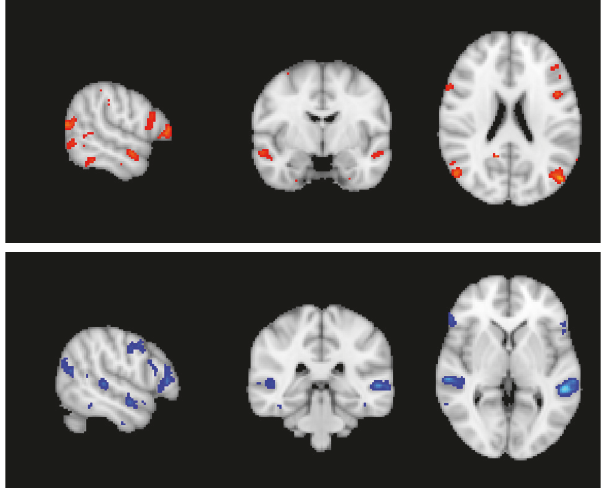
(c) Auditory group map of participants classified as bilateral hemisphere language dominant (top), visual group map of participants classified as bilateral hemisphere language dominant (bottom) (note: images are in radiological orientation, where